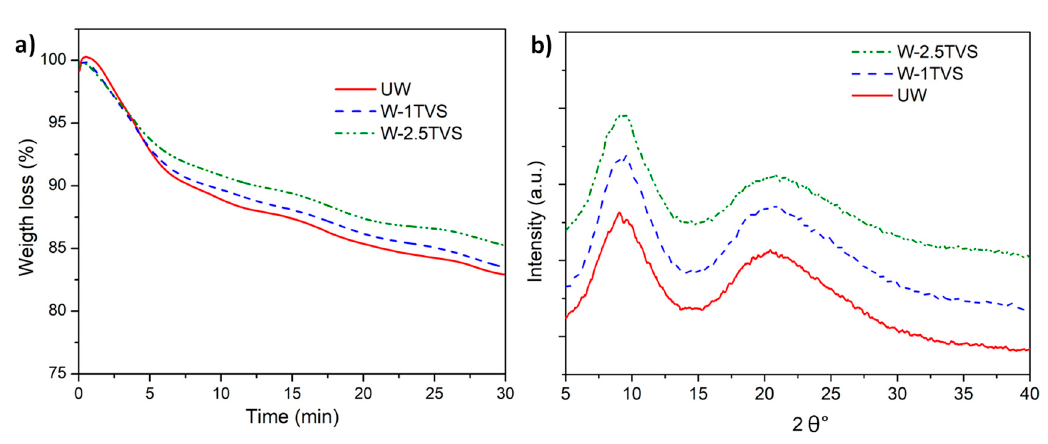
Figure 4. Untreated and silane-treated sheep wool fibers: ( a ) TGA isothermal curves and ( b ) XRD pattern.